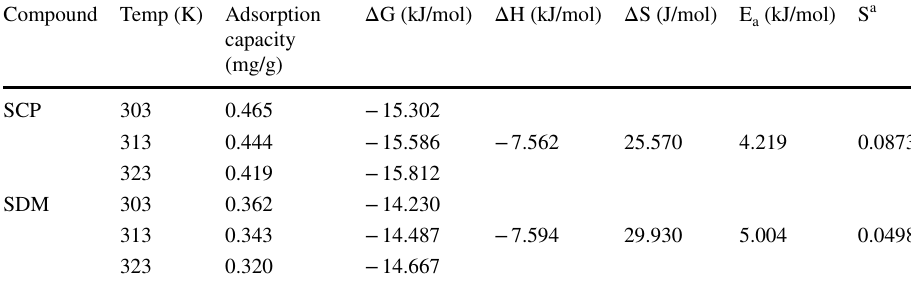
a Distinguish between entropy (S) and the sticking probability also denoted by